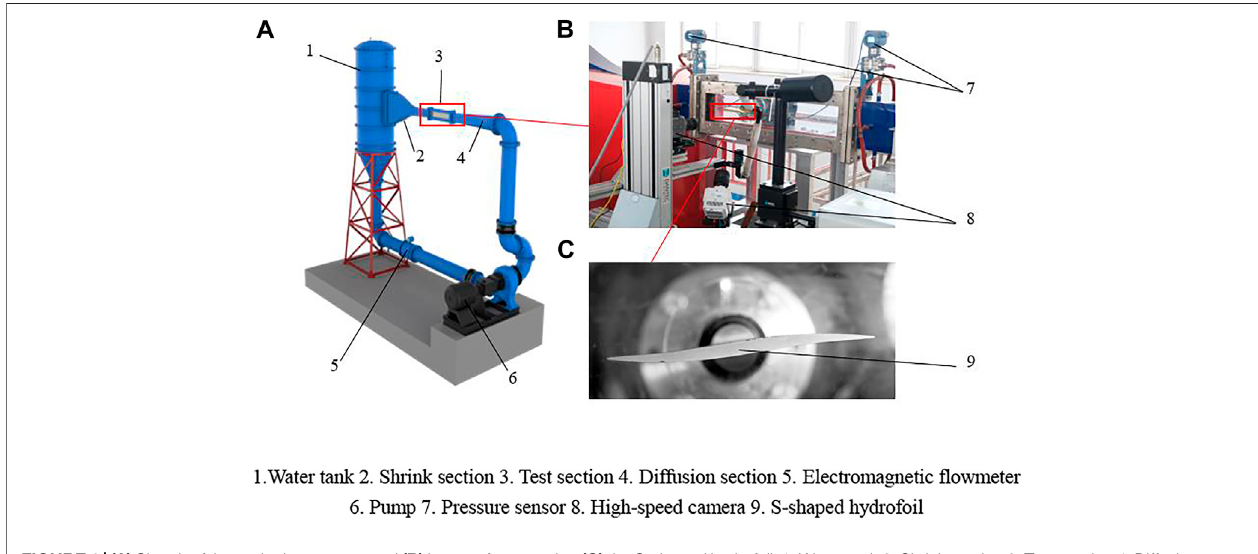
FIGURE1|(A) Sketchofthecavitationwatertunnel (B) imageoftestsection (C) theS-shapedhydrofoil.1.Watertank2.Shrinksection3.Testsection4.Diffusion section 5. Electromagnetic fl owmeter. 6. Pump 7. Pressure sensor 8. High-speed camera 9. S-shaped hydrofoil.